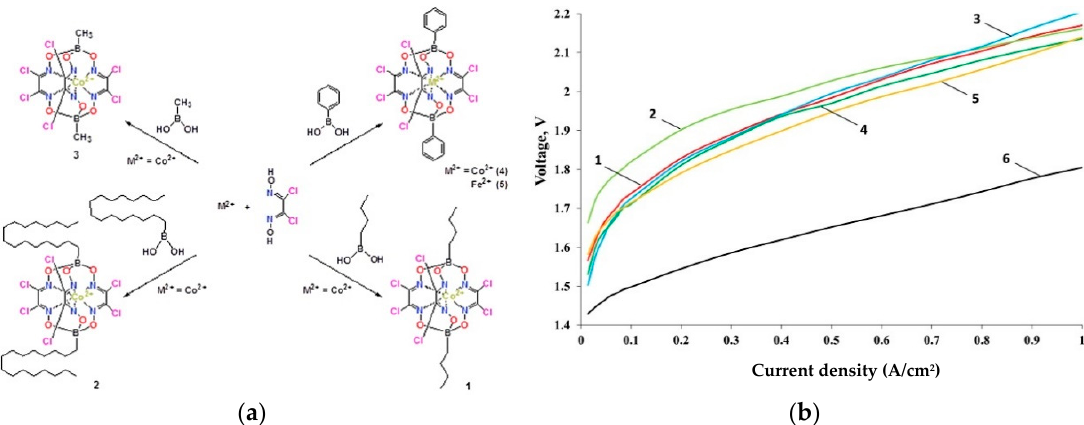
Figure 13. ( a ) Synthesis of the metal (II) hexachloroclthrochelates. ( b ) Current-voltage performances of MEAs with cathodes based on metal (II) clathrochelates Co(Cl 2 Gm) 3 (Bn-C 4 H 9 ) 2 (1), Co(Cl 2 Gm) 3 (Bn-C 16 H 33 ) 2 (2), Co(Cl 2 Gm) 3 (BCH 3 ) 2 (3), Co(Cl 2 Gm) 3 (BC 6 H 5 ) 2 (4) and Fe(Cl 2 Gm) 3 (BC 6 H 5 ) 2 (5) and